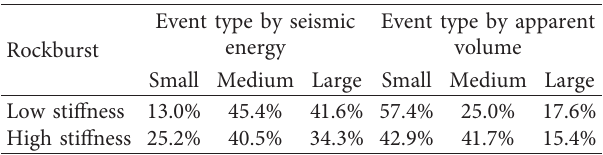
Figure 8: The source parameter space of the microseismic event during rockburst development stage. (E) for small-energy events, medium-energy events, and large-energy events, respectively. AV 1 � 200 and AV 2 � 400 are the threshold for small- volume events, medium-volume events, and large-volume events, respectively. Table 3: Statistics of microseismic event types in development stage of rockburst.